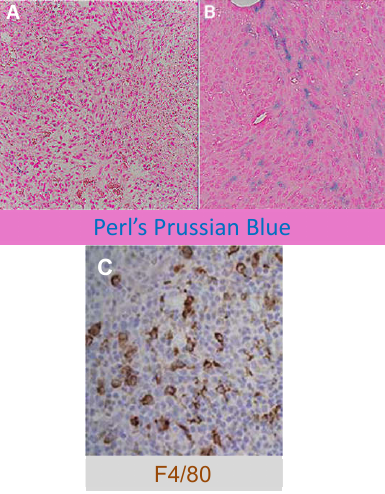
Figure 2. Iron staining and Immunohistochemistry of murine EF43. fgf4 tumors. ( A ) Perl’s Prussian blue stained control tumor tissue prior to ferumoxytol administration showing the absence of significant iron staining; ~0.4% of the cells were positive for iron. ( B ) Perl’s Prussian blue staining of a tumor section showing the presence of iron 24 h after the injection of the SPIONs. Approximately 25% of the cells were Fe + . ( C ) Tumor section stained for F4/80 immunoreactivity shows that approximately half of the cells are F4/80 +